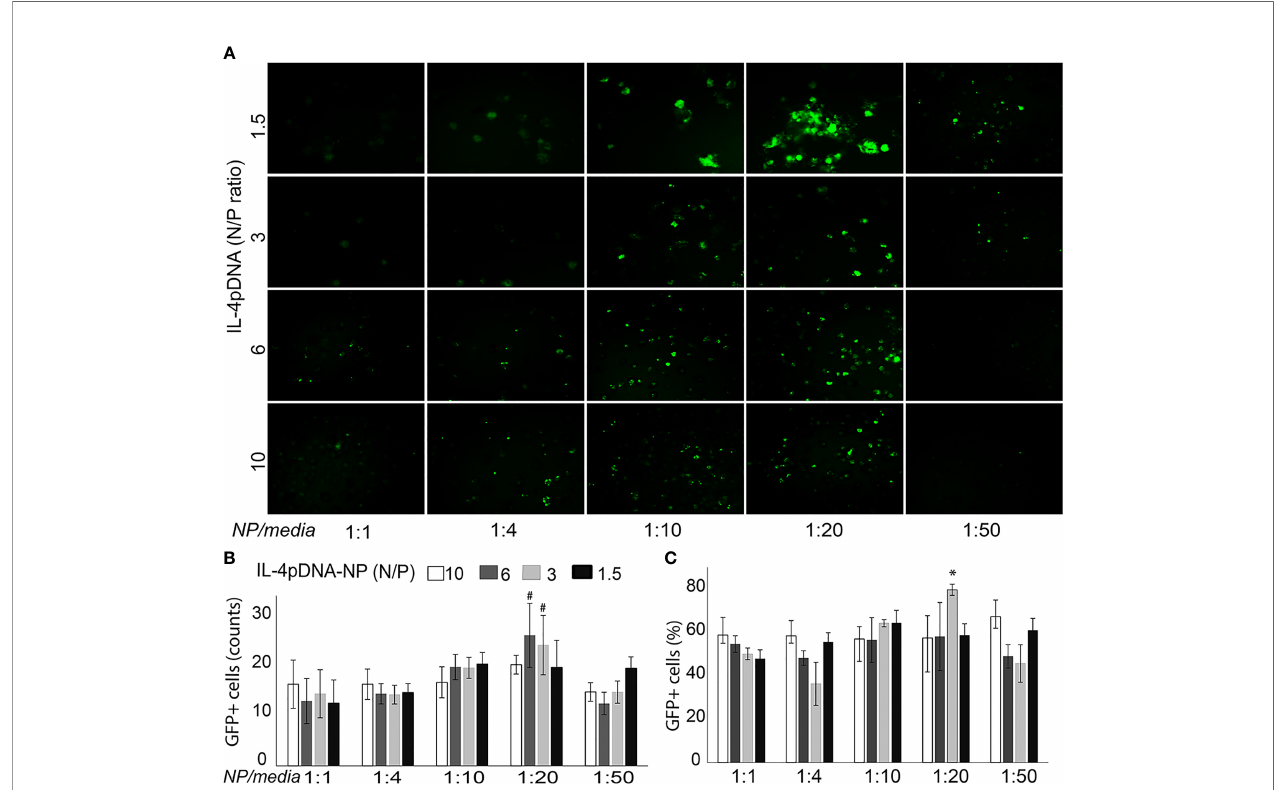
FIGURE 2 | Transfection of MDM by IL-4pDNA-NPs. (A) Fluorescence microscopy imaging of GFP+ MDM cells illustrates the transfection of IL-4pDNA/GFP-NPs at various N/P ratios of IL-4pDNA with different NP concentrations (NPs to culture media volume ratios). (B) The absolute numbers of GFP+ MDM were counted and the best transfection was obtained with IL-4pDNA/GFP-NPs at N/P ratios of 6 and 3 and NPs to culture media volume ratio of 1:20. (C) The percentages of GFP+ MDM were calculated and indicate the highest transfection occurred with 1.5 ng/ml of IL-4pDNA/GFP-NPs at a NPs to culture media ratio of 1:20. Error bars represent the standard error of the mean (s.e.m.). Note that all experiments were done in triplicate. * P<0.05 compared to all conditions; # P<0.05 represented N/P ratio at 3 or 6 to compare all conditions except between the N/P ratio at 6 and 3 in